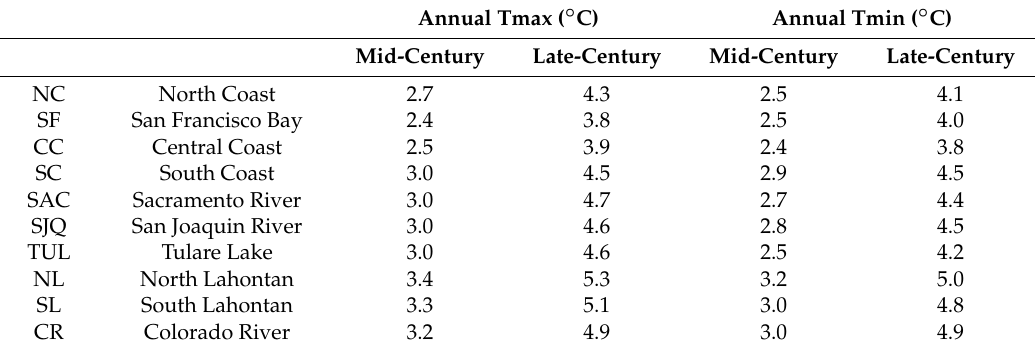
Figure 6. Differences ( ◦ C) between historical and mean RCP 4.5 projections on mean annual: ( a ) maximum temperature in mid-century; ( b ) minimum temperature in mid-century; ( c ) maximum temperature in late-century; and ( d ) minimum temperature in late-century. Table 4. Differences ( ◦ C) between historical and mean RCP 8.5 projections on annual maximum and minimum